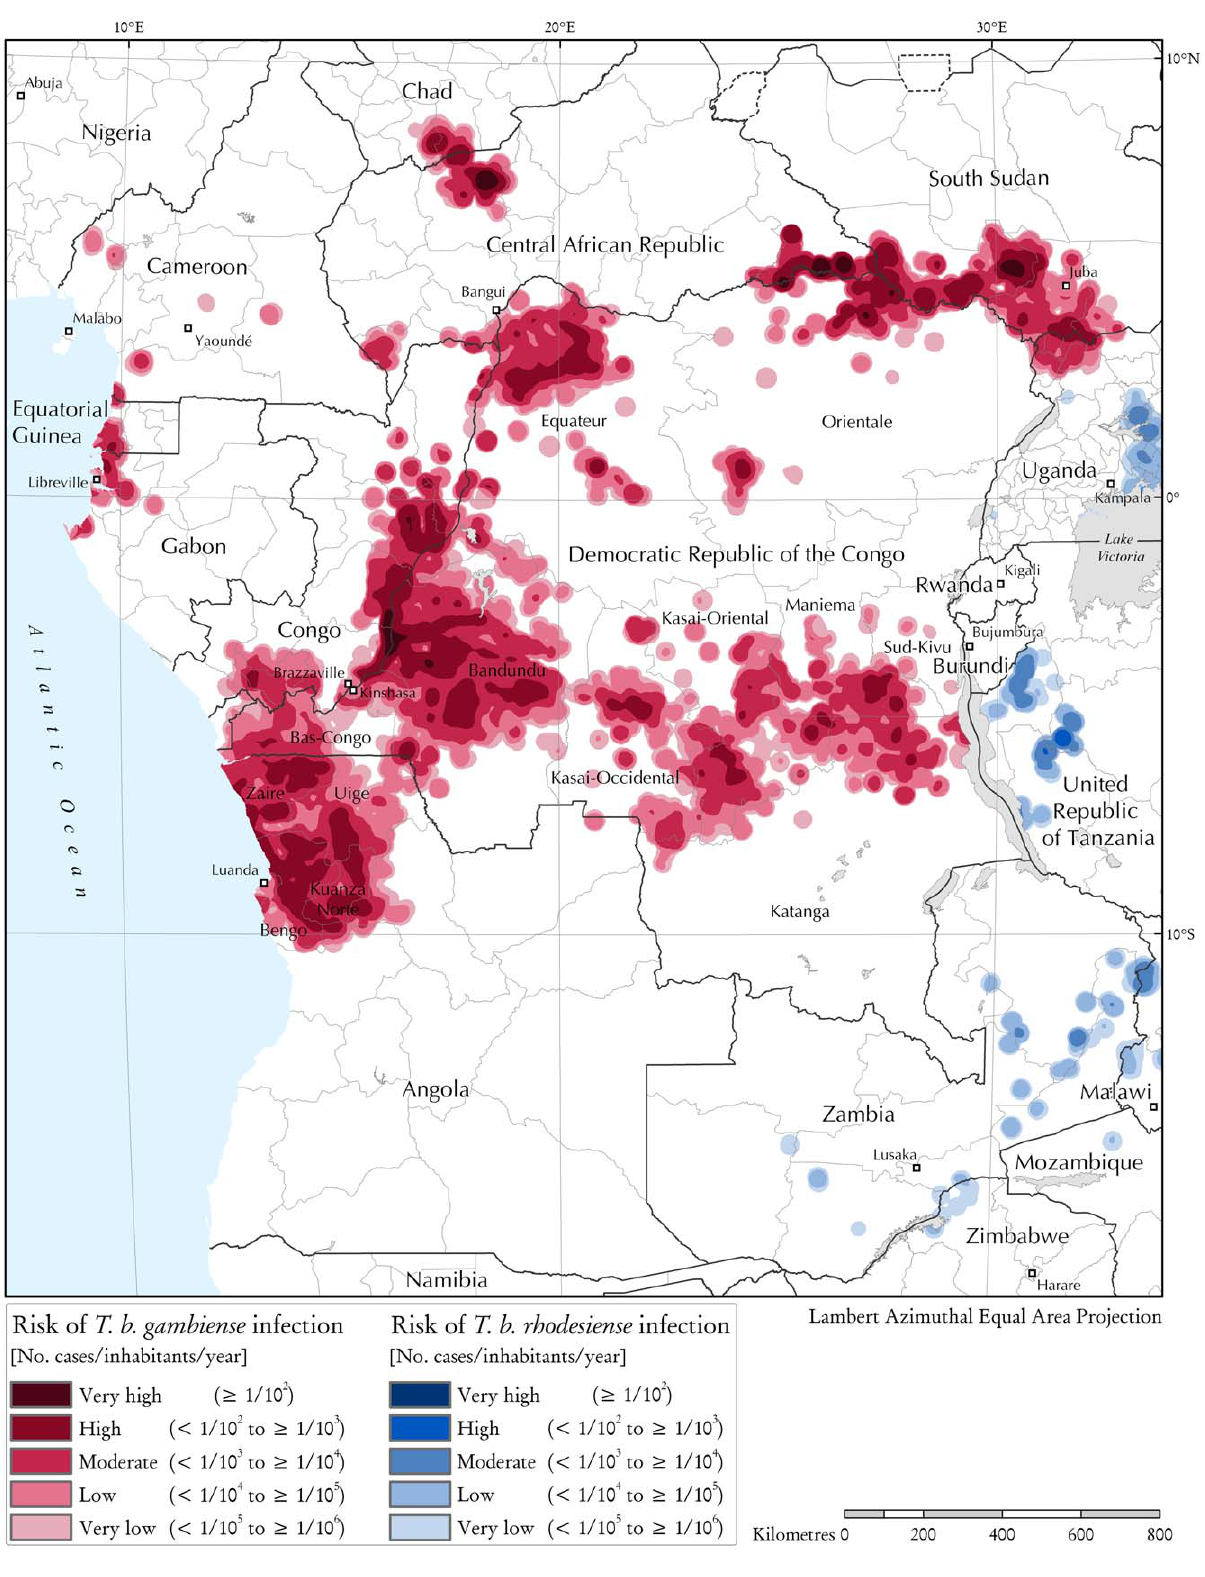
Figure 3. The risk of T.b.gambiense infection in central Africa (2000–2009).